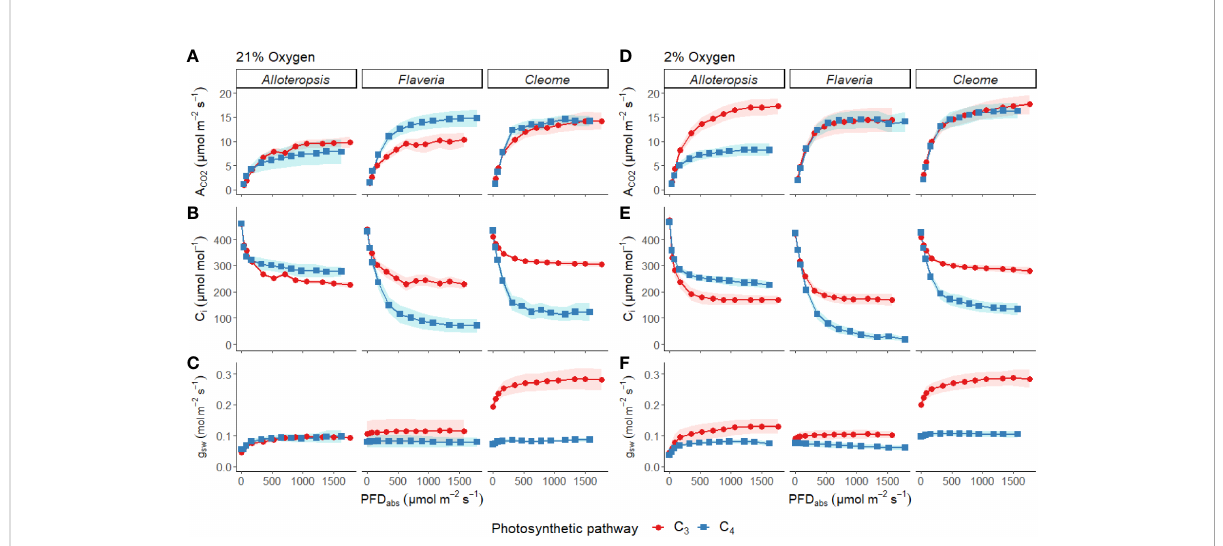
FIGURE 2 Measurements of gas exchange traits during light response curves for phylogenetically linked C 3 and C 4 Alloteropsis , Flaveria and Cleome species under 21% and 2% O 2 . Plots show net CO 2 assimilation (A CO2 , A, D ), intercellular CO 2 concentration (C i , B, E ), and stomatal conductance to water vapour (g sw , C, F ) as a function of absorbed light intensity. Ribbons represent standard error of the mean